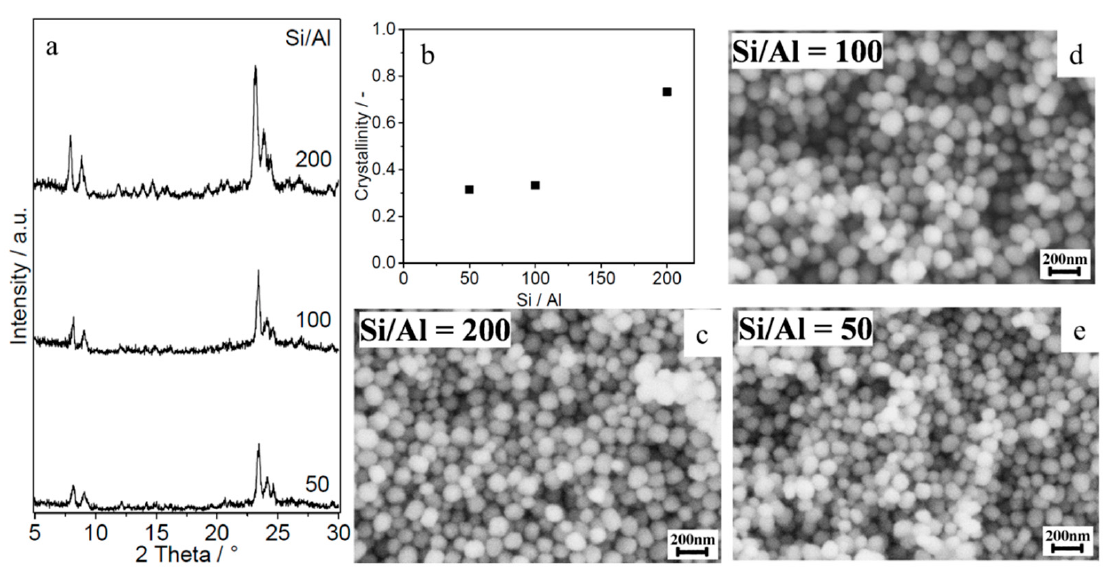
Figure 3 . ( a ) XRD diffraction patterns of dried suspensions prepared from starting synthesis gels with different Si/Al ratios ( b ) the crystallinities reached after 22 h of hydrothermal synthesis time. Higher Si/Al ratios result in higher yields of nanosized zeolites. ( c – e ) SEM images of nanosized zeolites with different Si/Al ratios after centrifugation and washing. The particle size depends on the Si/Al ratio.